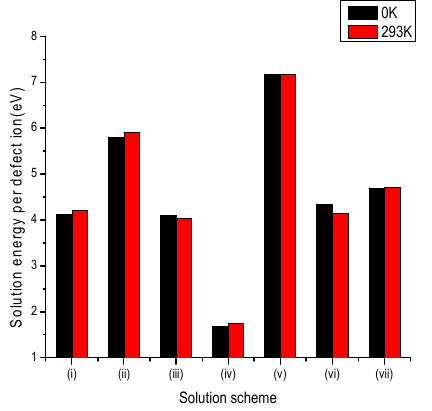
Figure 2. Bar chart of solution energies vs. solution schemes for trivalent dopant (V 3 + ) at the Li and Nb sites, considering the first neighbours in relation to the c axis.